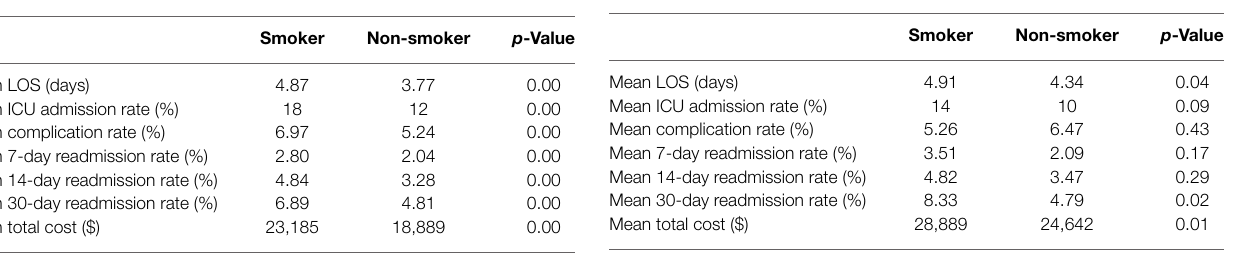
TABLE3 | Outcomesofpatientsadmittedforspinaltreatmentforcongenital disease .